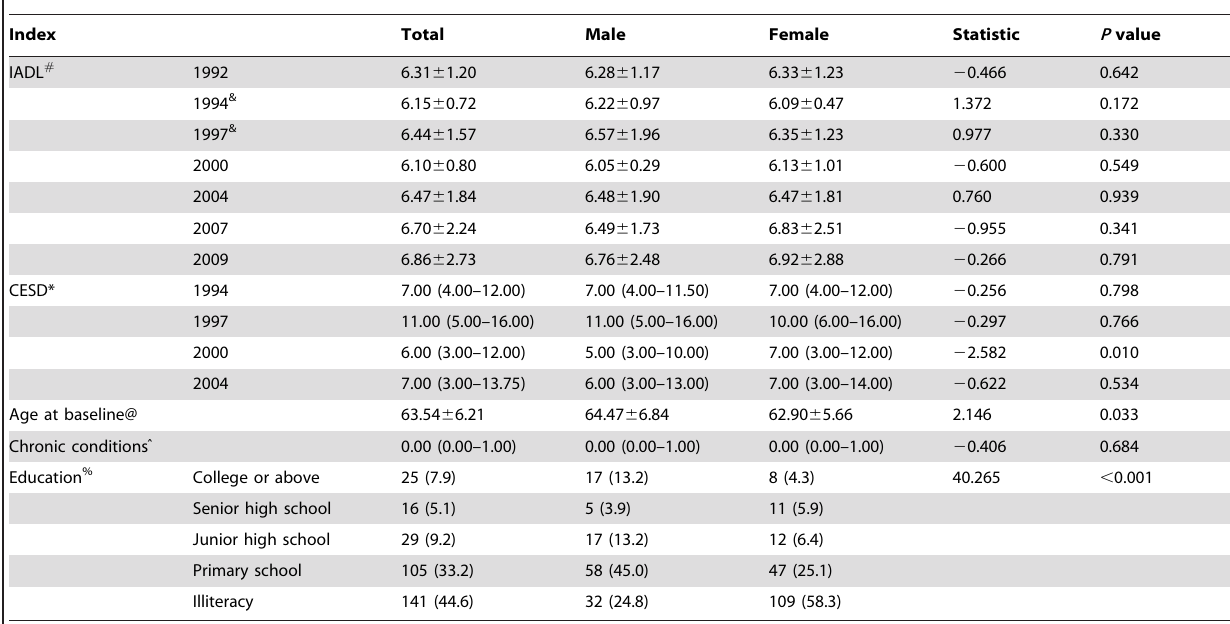
Table 1. Characteristics and IADL and CES-D score for